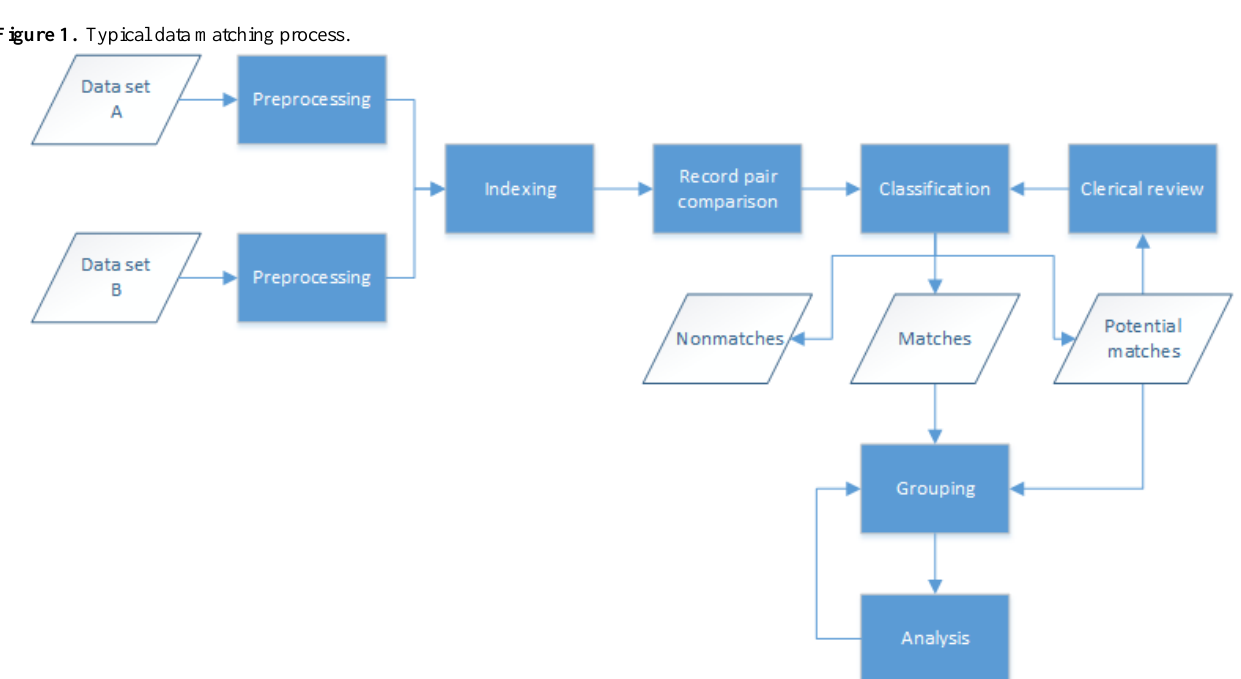
Figure 1. Typical data matching